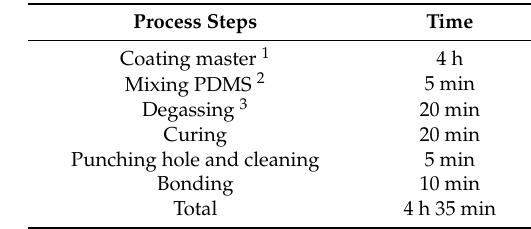
Table 3. The estimated time of fabricating the poly(dimethylsiloxane) (PDMS) device.